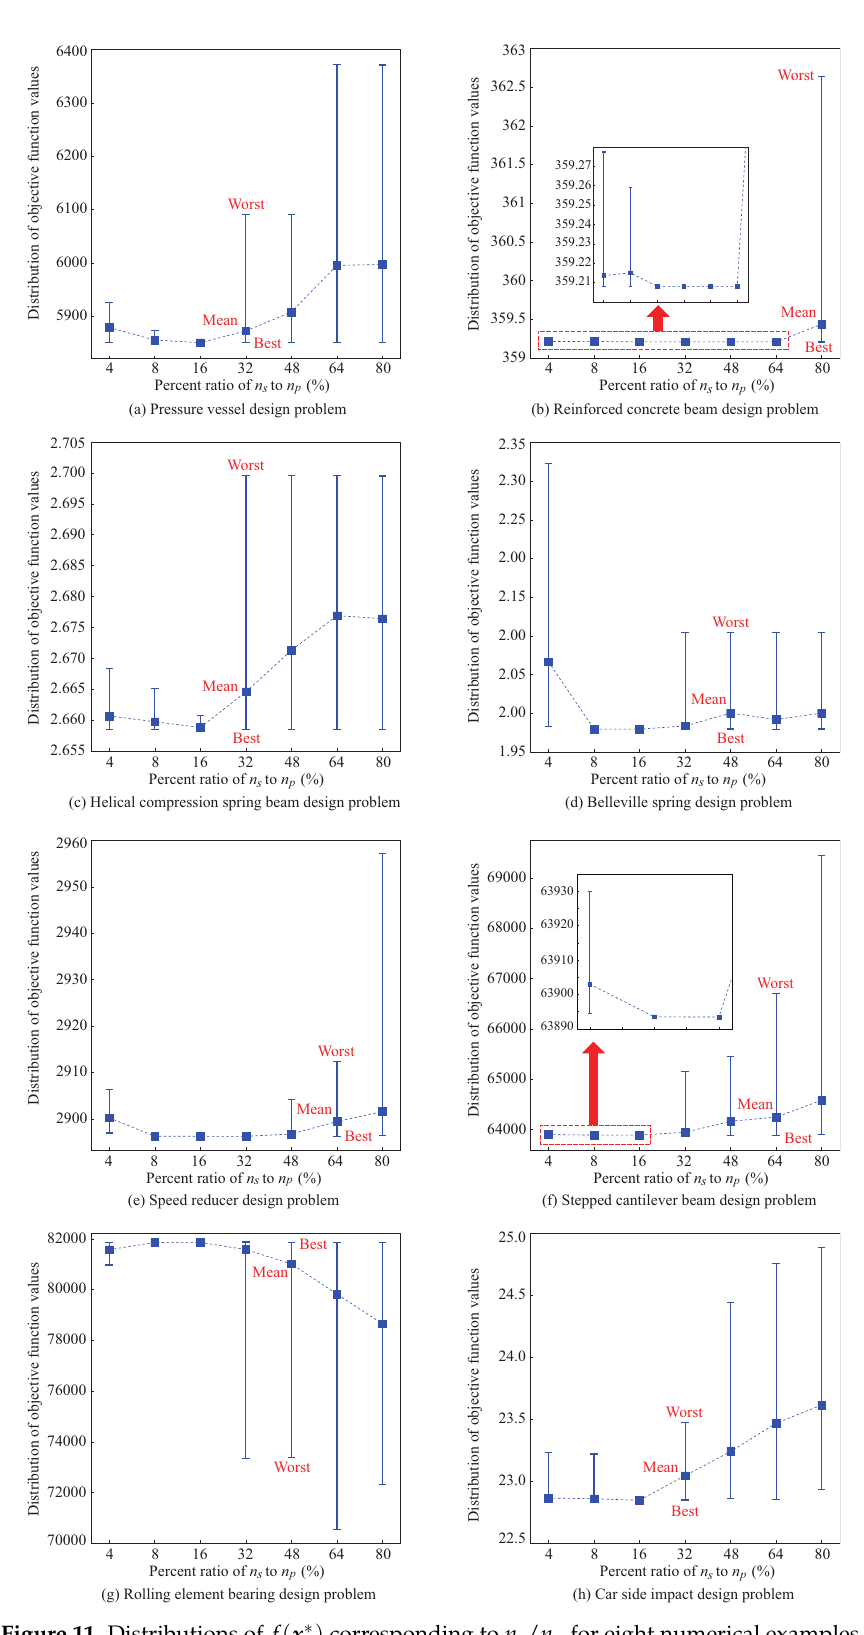
Figure 11. Distributions of f ( x ∗ ) corresponding to n s / n p for eight numerical